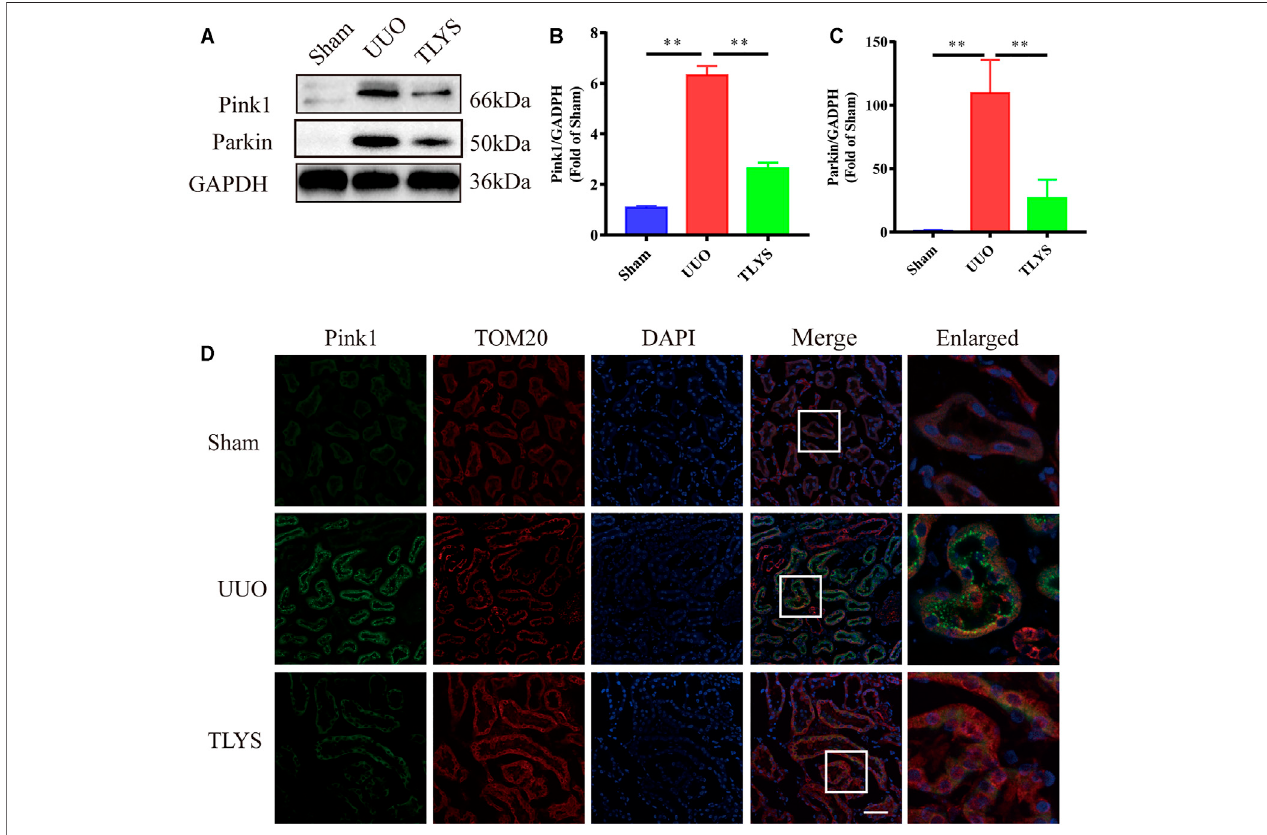
FIGURE 8 | TLYS decoction alleviated Pink1/Parkin-mediated mitophagy in the rats with UUO. (A-C) The expression of Drp1, Pink1, Parkin and Mfn2 by Western blot ( n (cid:2) 6) and analyzed semi-quantitatively. (D) Images oftissuesco-stained for themitochondrial markers Pink1 (green), TOMM20 (red) and nuclear (blue), scale bar (cid:2) 50 μ m, ( n (cid:2) 6). Data were presented as means ± SEM. * p < 0.05, ** p < 0.01.